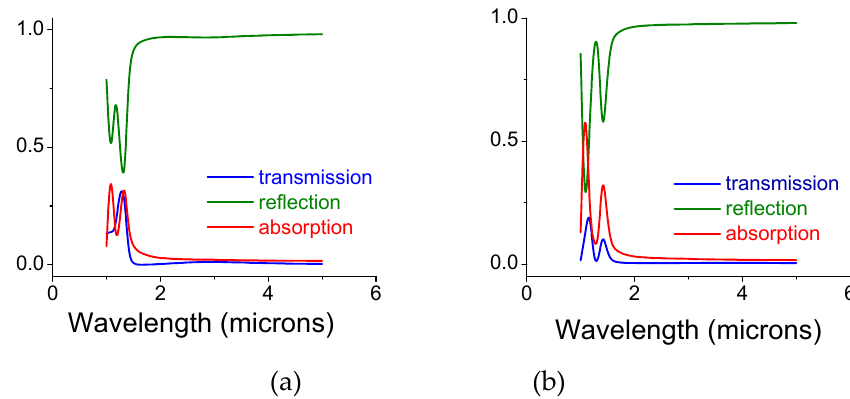
Figure 4. Intensity coefficients, transmission, reflection, and absorption for a diagonally shifted bi-layer screen whose air gap is filled with silica colloids in air. The opening and disk diameters are 0.5 and 0.7 microns, respectively. ( a ) The gap is 0.25 microns. ( b ) The gap is 0.5 microns. The thickness of each copper mono-screen is 0.1 microns and the diameter of the colloids equals the gap size.